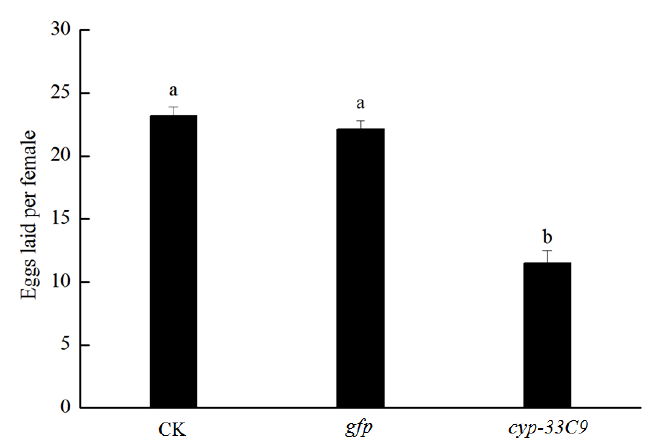
Figure 2. The oviposition of Bursaphelenchus xylophilus after RNA interference of cyp-33C9 . The bars indicate standard deviation, and different letters indicate significant differences ( p < 0.05) among treatments.